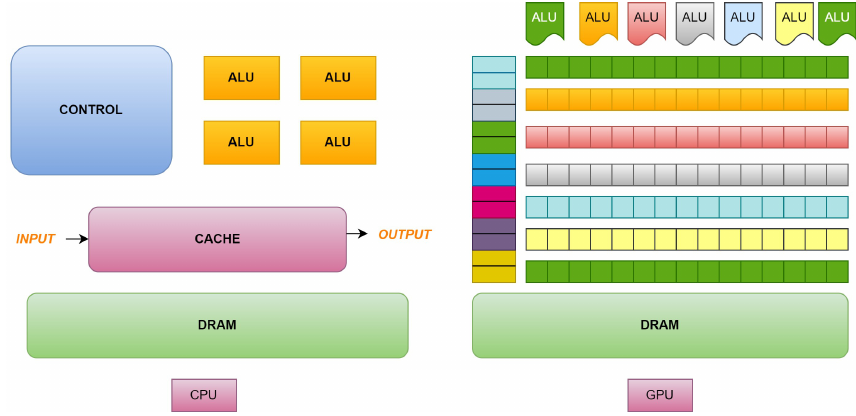
Figure 3. General architecture of GPU versus